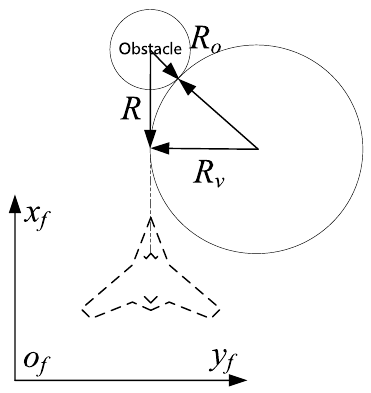
Figure 2. Schematic diagram of UAV obstacle